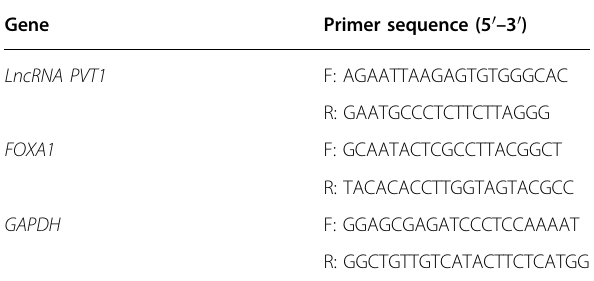
Table 1 Primer sequence of RT-qPCR Gene Primer sequence (5 ′ – 3 ′